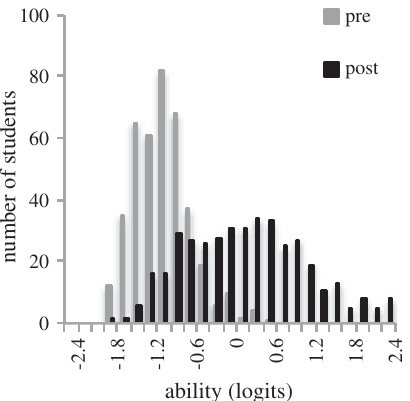
FIG. 25. The pre- and postability histograms for class 11.